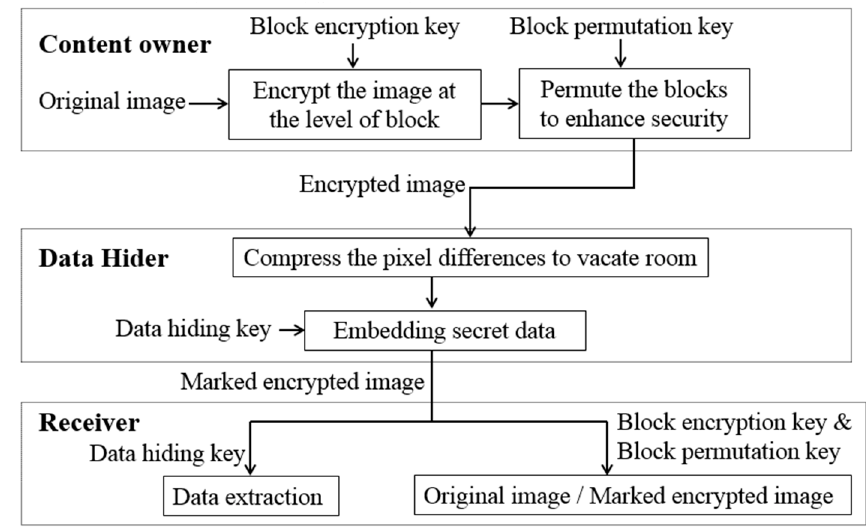
Figure 1. The framework of the proposed